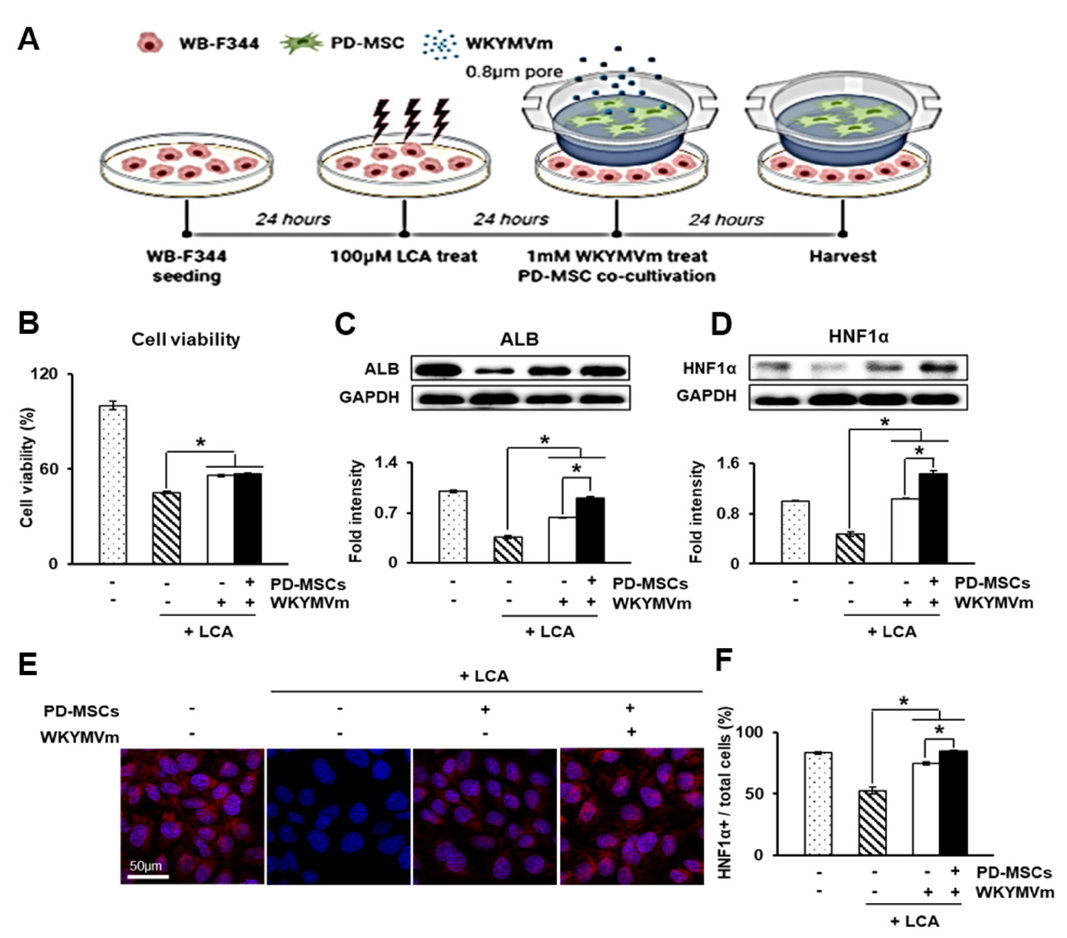
Figure 7. PD-MSCs combined with WKYMVm can regenerate damaged hepatocytes in vitro. ( A ) Schematic figure of WB-F344s cell in vitro modeling. ( B ) Cell viability of the LCA-treated WB-F344s cells shown by CCK-8 assays. Protein expression of ALB ( C ) and HNF1 α ( D ) shown using Western blots. Protein expression was normalized to GAPDH expression through Western blot bands. ( E ) Localization and expression of translocated HNF1 α in the nucleus shown through immunofluorescence. ( F ) Quantification of translocated HNF1 α -positive WB-F344s versus total WB-F344s using immunofluorescence. n = 3 per group, mean ± SD, *, p < 0.05 by t tests.